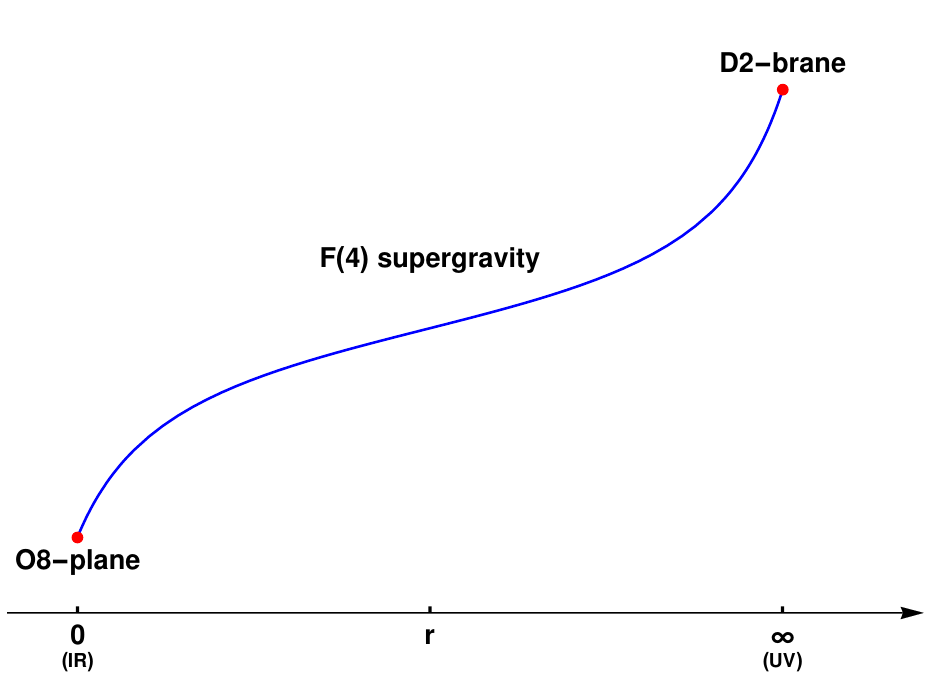
Figure 4 . A cartoon represenation of the F (4) solution as it interpolates from the O 8 -plane in the IR to the D 2 -brane in the